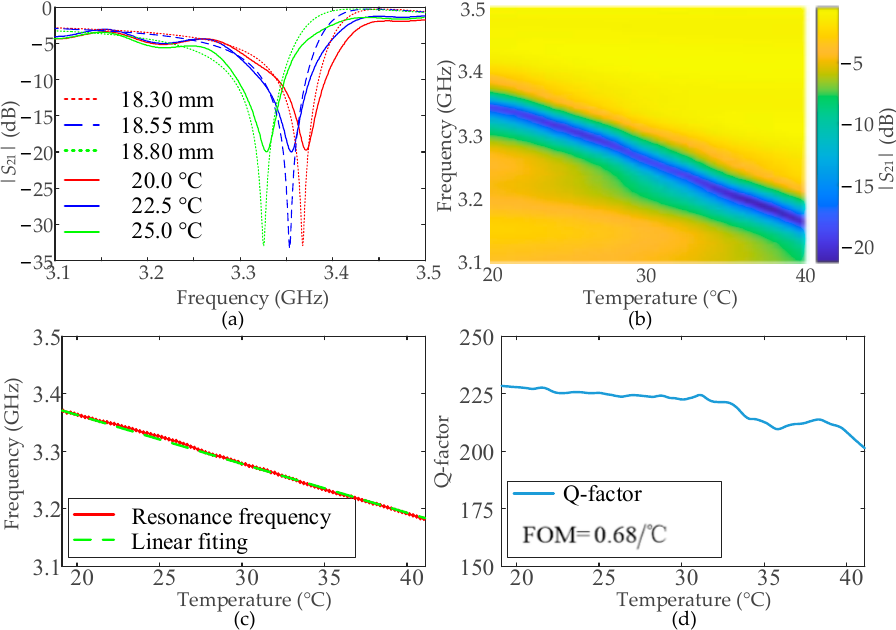
Figure 5. ( a ) Simulated and measured | S 21 | curves at different Hg bar lengths and temperature values, respectively, and ( b ) measured transmission 2D spectrum for the fabricated Hg-EIT-like metamaterial unit; ( c , d ) the collected resonance frequency shift and calculated Q-factor, and FOM.